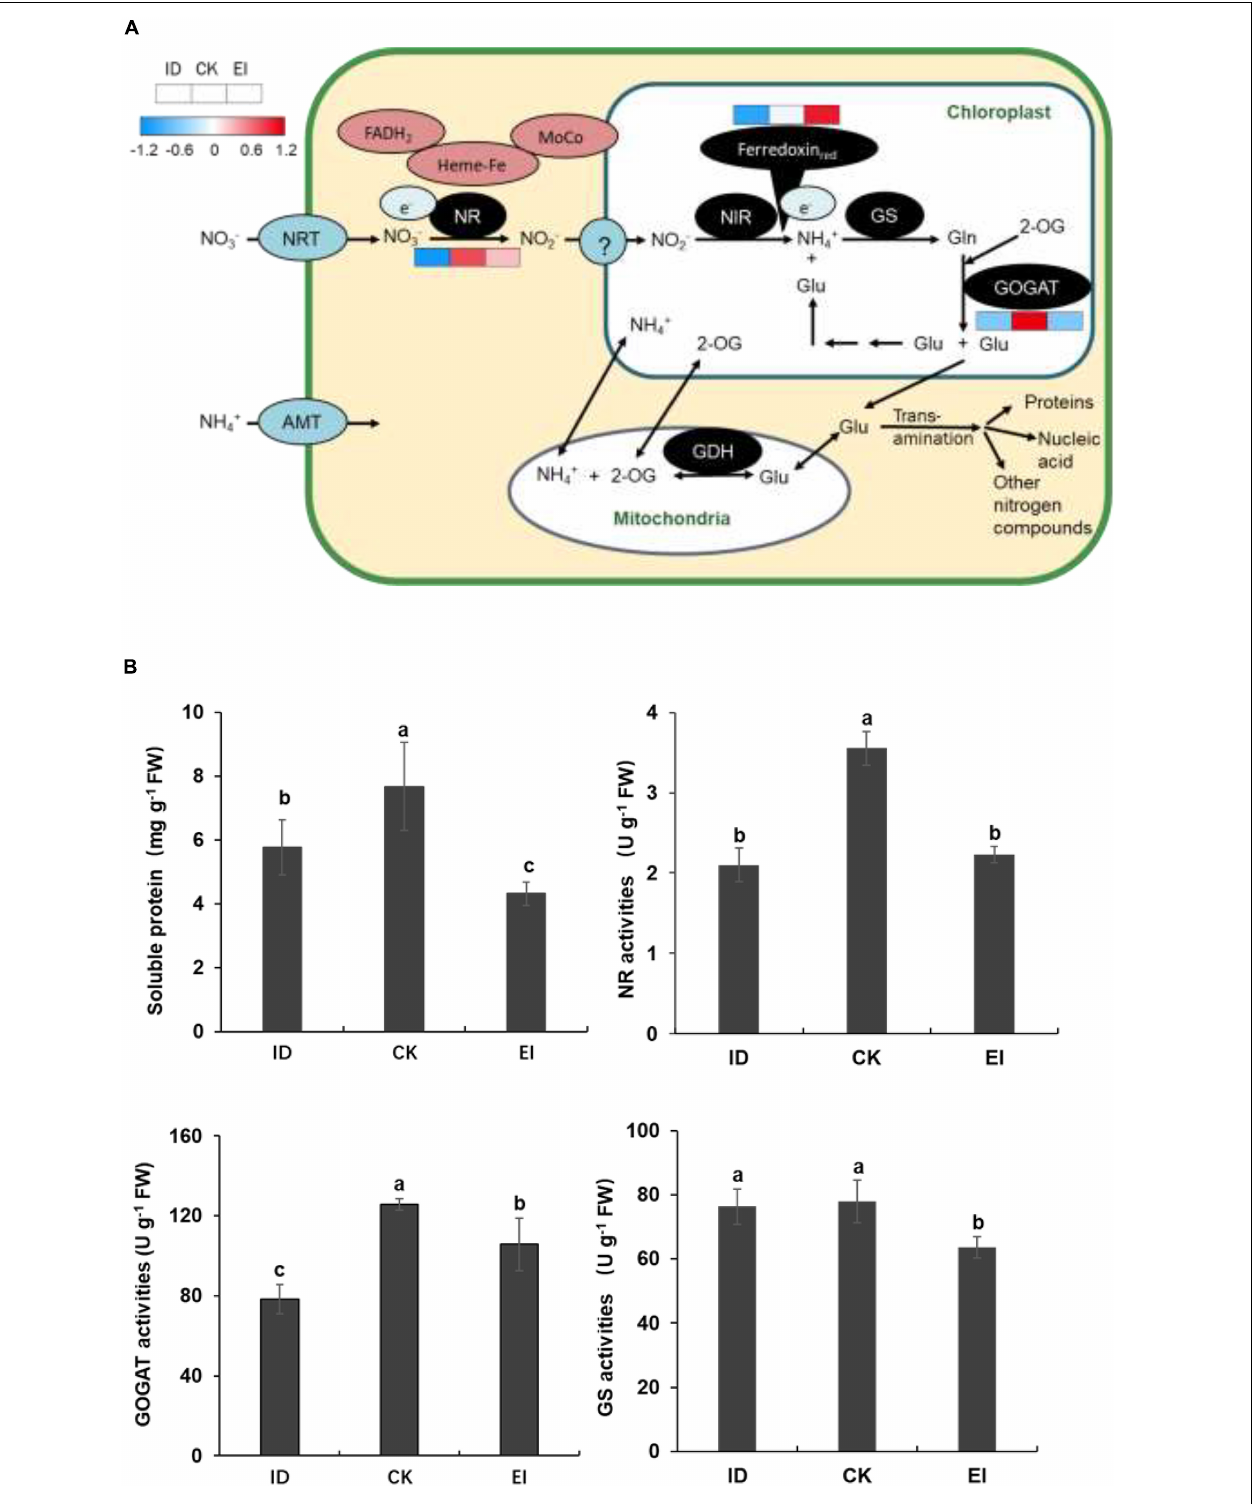
FIGURE 9 | Nitrogen assimilation pathway and activities of key enzymes related with N metabolism in ID, CK, and EI leaves. (A) Pathway viewer of main N metabolism in A. catechu leaf. Heat maps were drawn using log2 -transformed FPKM values. (B) Comparison of soluble protein, Nitrate reductase (NR), glutamate synthase (GOGAT), and glutamine synthetase (GS). The small bars show standard deviation. Different letters represent significant differences at P < 0.05 according to Duncan’s multiple range tests.